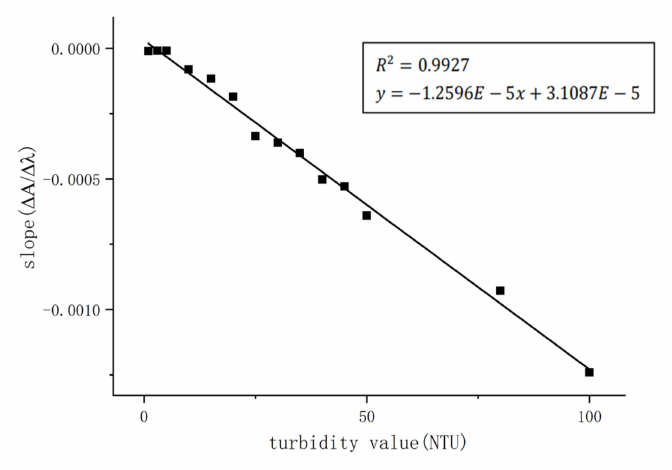
Figure 6. Fitting relationship between slopes and turbidity